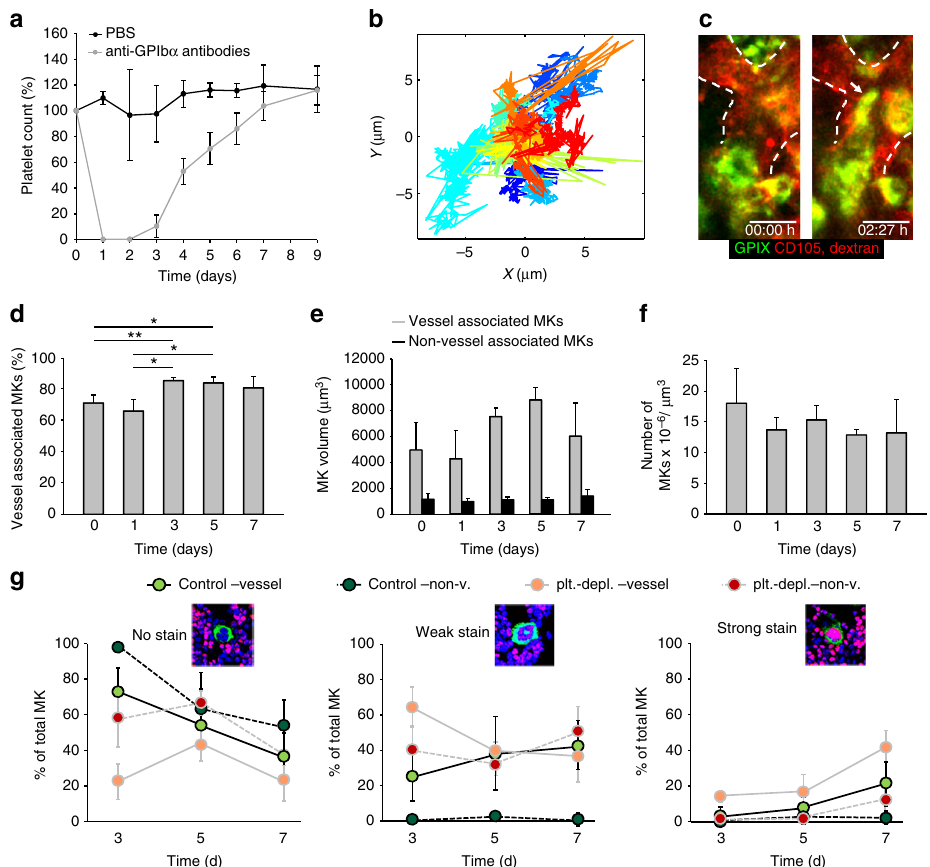
Fig. 5 Platelet depletion does not affect MK distribution or migration within the BM. a Mice displayed severe, but reversible thrombocytopenia after platelets were depleted by anti-GPIb α antibodies ( fi ve mice per group). b Trajectories of individual MKs in cranial BM on d3.5 after platelet depletion; each color represents one MK track. c A representative MK that remained sessile for 2.5 h before starting to form proplatelets in a vessel ( dashed line ) (see also Supplementary Movie 10; scale bar 20 µ m). d – f Sterna were analyzed by LSFM on day 1, 3, 5, and 7 following platelet depletion ( fi ve mice per day). Bar graphs represent mean ± SD. Increase in vessel associated MKs upon platelet depletion d correlates with an increase in MK-volume of vessel associated ( gray bars , e ) but not of non-vessel associated MKs ( black bars , e ). f Total MK numbers remain unaltered. Bar graphs represent mean ± SD. * p < 0.05, ** p < 0.01 (Mann – Whitney U test). There are no signi fi cant differences in e or f ( p > 0.05; one-way ANOVA). g DNA synthesis rate in MKs in vivo after platelet depletion ( fi ve mice per day). Femur bones were sectioned and stained for EdU ( red ), which is incorporated into nuclei ( blue ). MKs are stained with anti-CD41 antibody ( green ). EdU incorporation was detected in vessel-associated (vessel) and non-vessel-associated (non-v.) MKs at the indicated time points in platelet depleted (plt-depl) and control injected